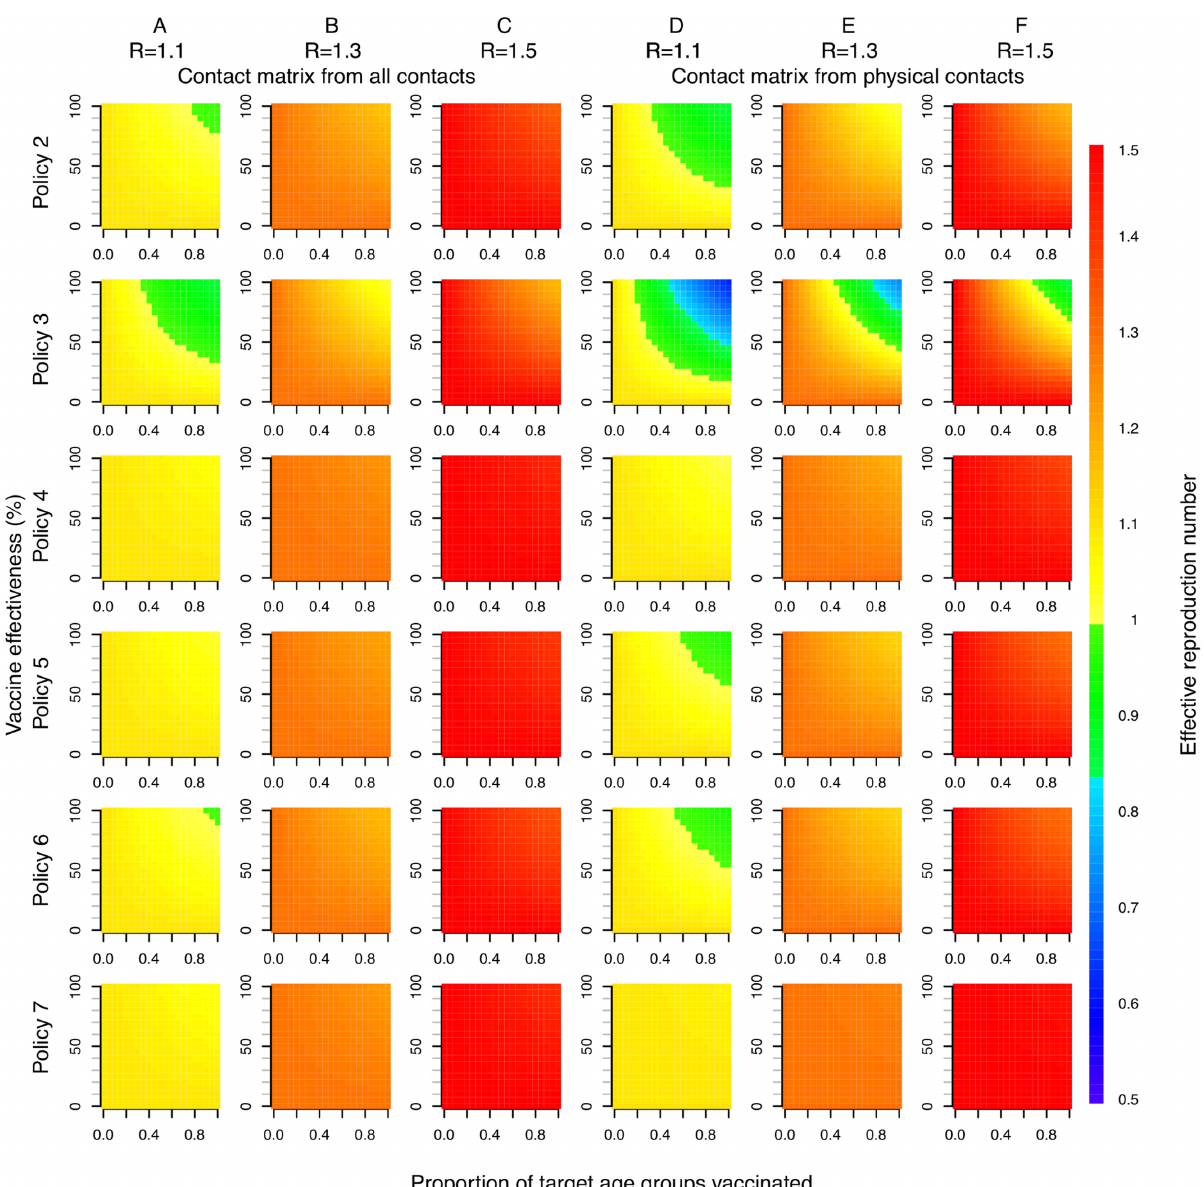
Fig 6. Effective reproduction number as a function of vaccination policy, coverage, and vaccine effectiveness. Color indicates effective reproduction number after vaccination. Columns A, B, and C use a contact matrix derived from all contacts recorded. Columns D, E, and F use a contact matrix derived from physical contacts only. In both cases, baseline immunity assumptions at the start of each influenza season are taken as the mean estimated for each of the six age groups when fitting to data under base case assumptions (21%, 25%, 33%, 33%, 38%, and 37%). R values in column headings indicate the assumed effective reproduction number prior to